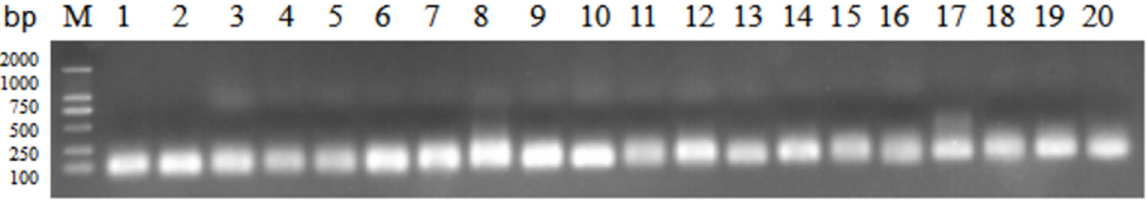
Figure 1. Agarose gel (1.5%) analysis of SLOPE products of AMPs. M, DL2000 DNA marker. Lane 1–20, represents AMPs 1–20 SLOPE products.